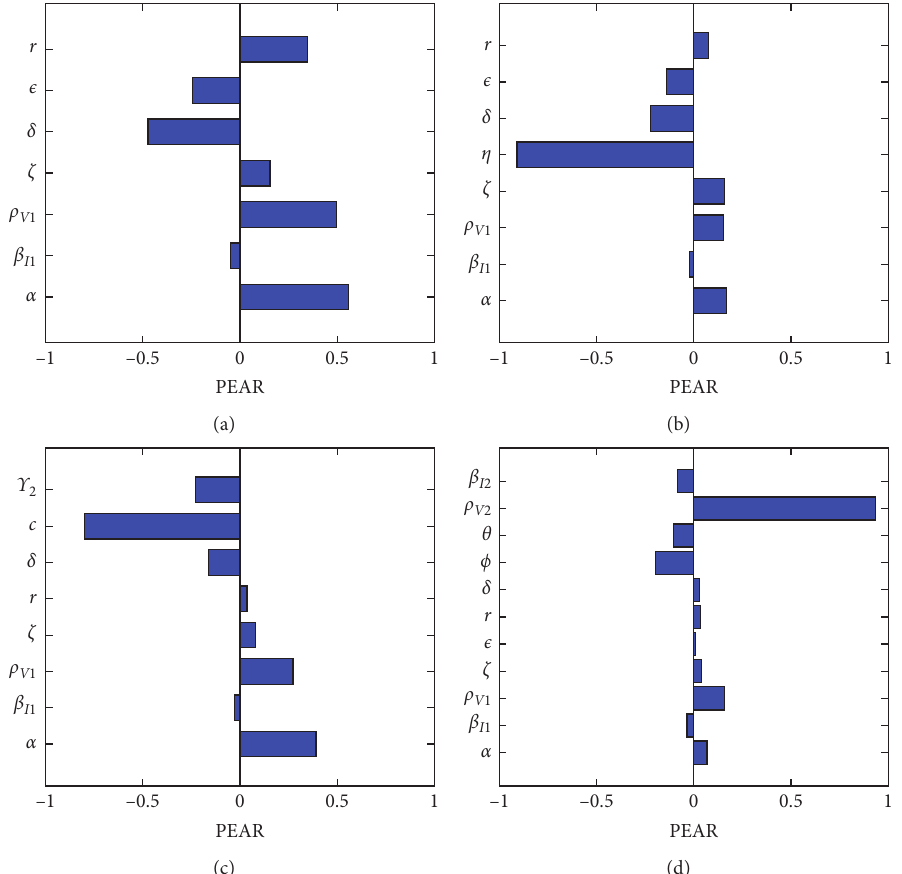
Figure 5: Parameter sensitivity analysis using Person correlation coefficient (PEAR) in (a) baseline case and three control scenarios, (b) medication, (c) test-and-cull, And (d)